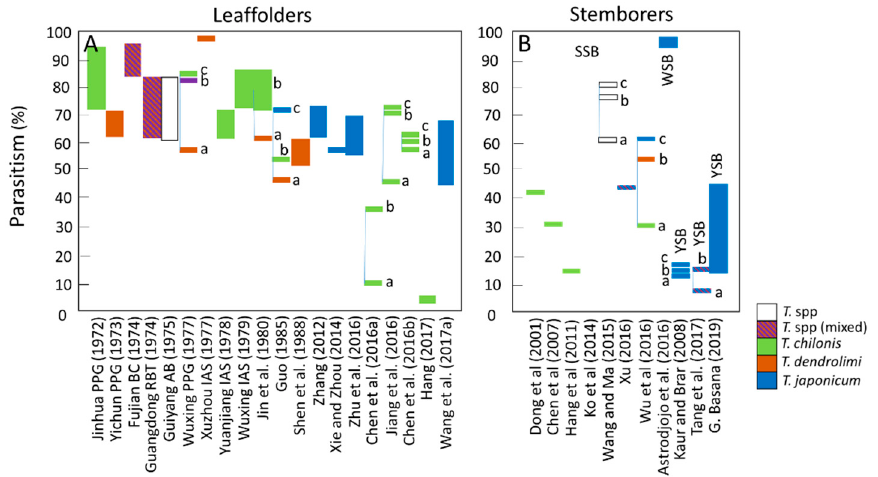
Figure 3. Parasitism rates reported from field studies using Trichogramma spp. as biological control agents against rice leaffolders in China ( A ) and against rice stemborers in China, Indonesia and India ( B ). Results have been reported as ranges in some studies (tall bars) and means in other (short bars). Bar colors indicate Trichogramma species as shown in the legend. Note that some studies compared Trichogramma species (indicated by lowercase letters associated with different species in the same study) or compared different release methods (indicated by lowercase letters associated with the same species in one study, i.e., Chen et al. (2016) [82], a = 90 K, b = 144 K released; Jiang et al. (2016) [83], a = 300 K, b = 450 K, c = 600 K; Chen et al. (2016) [81], a = 150 K, b = 450 K, c = 750 K; Wang and Ma (2015) [122], a = 1×, b = 2× and c = 3× releases; Kaur and Brar (2008) [130], a = 100 K, b = 125 K, c = 150 K; Tang et al. (2017) [124], a = 50 K, b = 100 K). Stemborers included WSB (Astrodjojo et al. (2016) [142], YSB (Kaur and Brar (2008) [130], Tang et al. (2017) [124] and G. Basana et al. (2019) [136]), and SSB (all other studies in ( B )) (See Table S1 for further